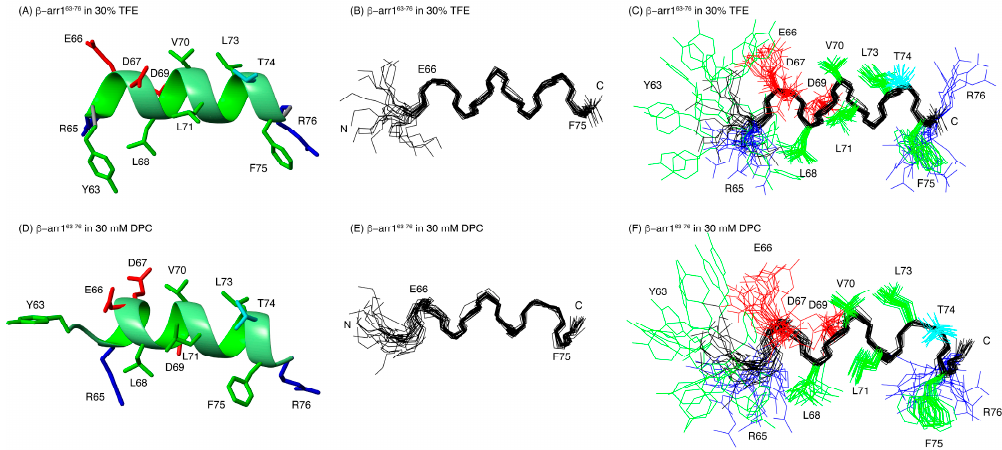
Figure 5. NMR structure of β -arr1 63-76 in 30 % TFE ( A – C ) and in DPC micelles ( D – F ). Ribbon representation of the lowest target conformer of the structural ensemble ( A , D ). Overlay of the backbone atoms of the 20 lowest target function conformers ( B , E ). The side-chains are shown in panels A , C , D and E . The aliphatic and aromatic side chains are displayed in green, the Glu and Asp side chains in red, the Arg and Lys side chains in blue, and the Thr side chains in cyan.